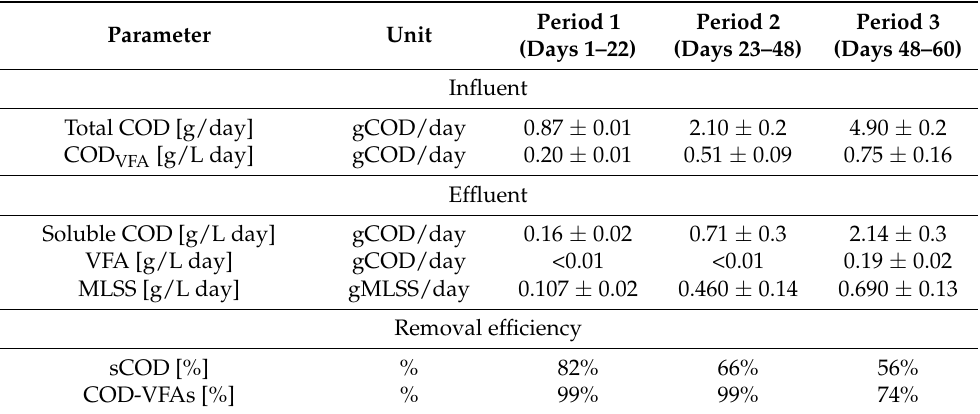
Table 3. Summary of the main results obtained during the HRT tested with Thauera sp. Sel9. Parameter